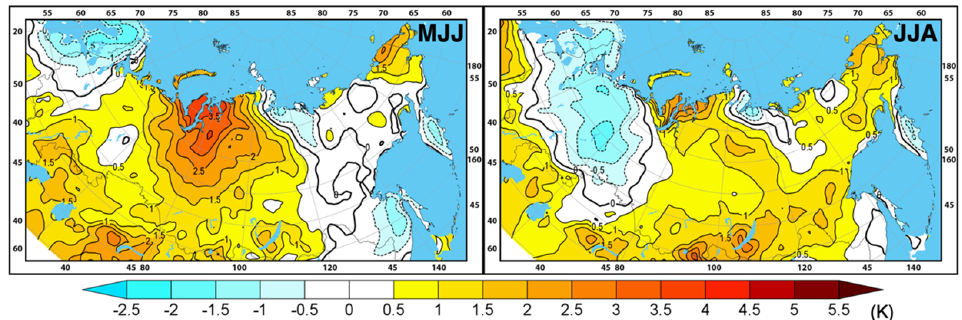
Figure 4. Spatial distributions of mean SAT anomalies in MJJ and JJA in 2015 with the E → E transitions from ERA ‐ Interim reanalysis data.